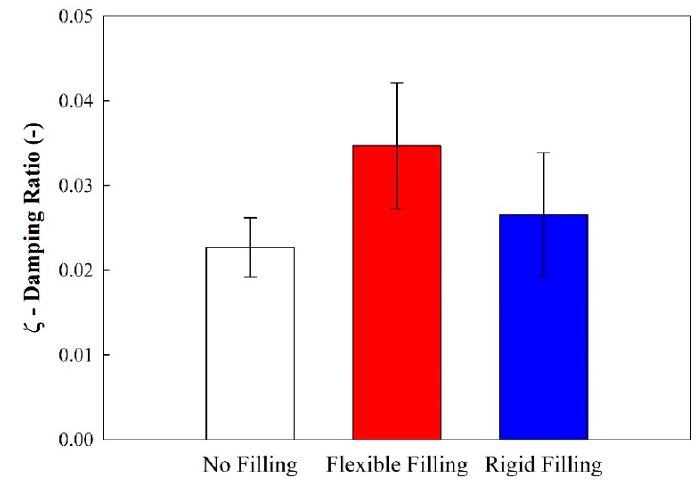
Figure 8. Average damping ratios ( ξ ) from the vibration testing.